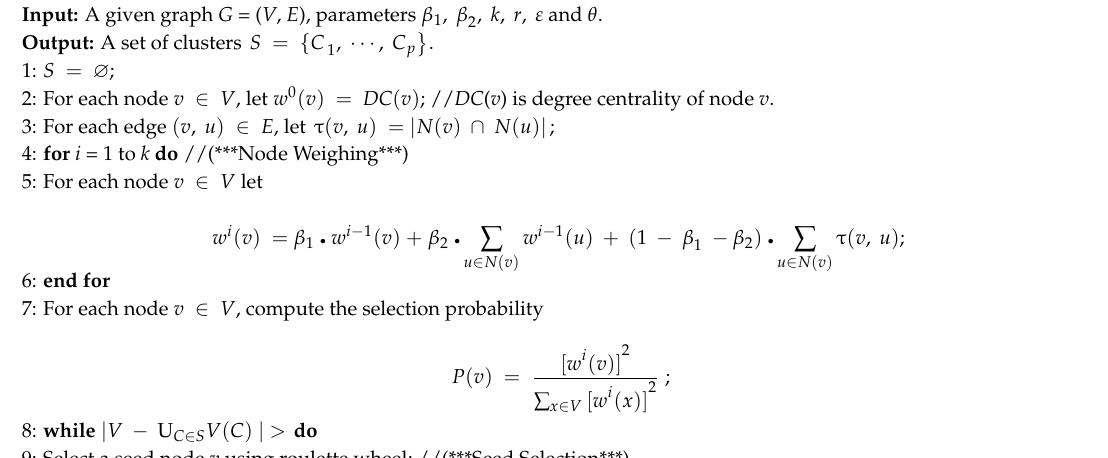
Algorithm 1. A seed-expansion graph clustering method